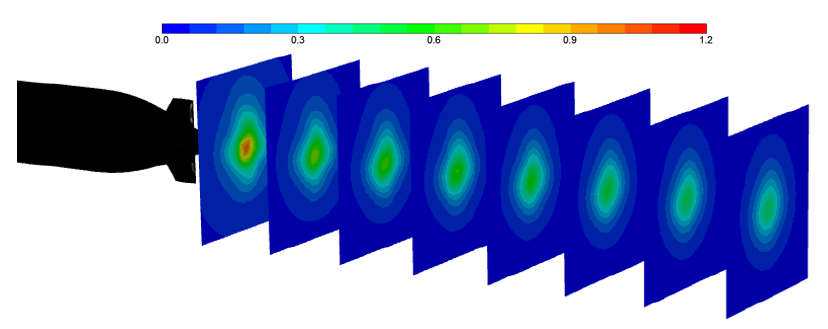
Figure 6. Cross section view of the wake flow for 10 s.